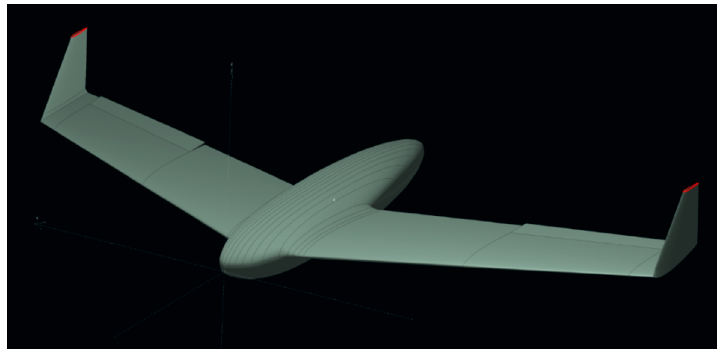
Figure 3. Isometric view of HORNET and fuselage with cross-sections defining its geometry.